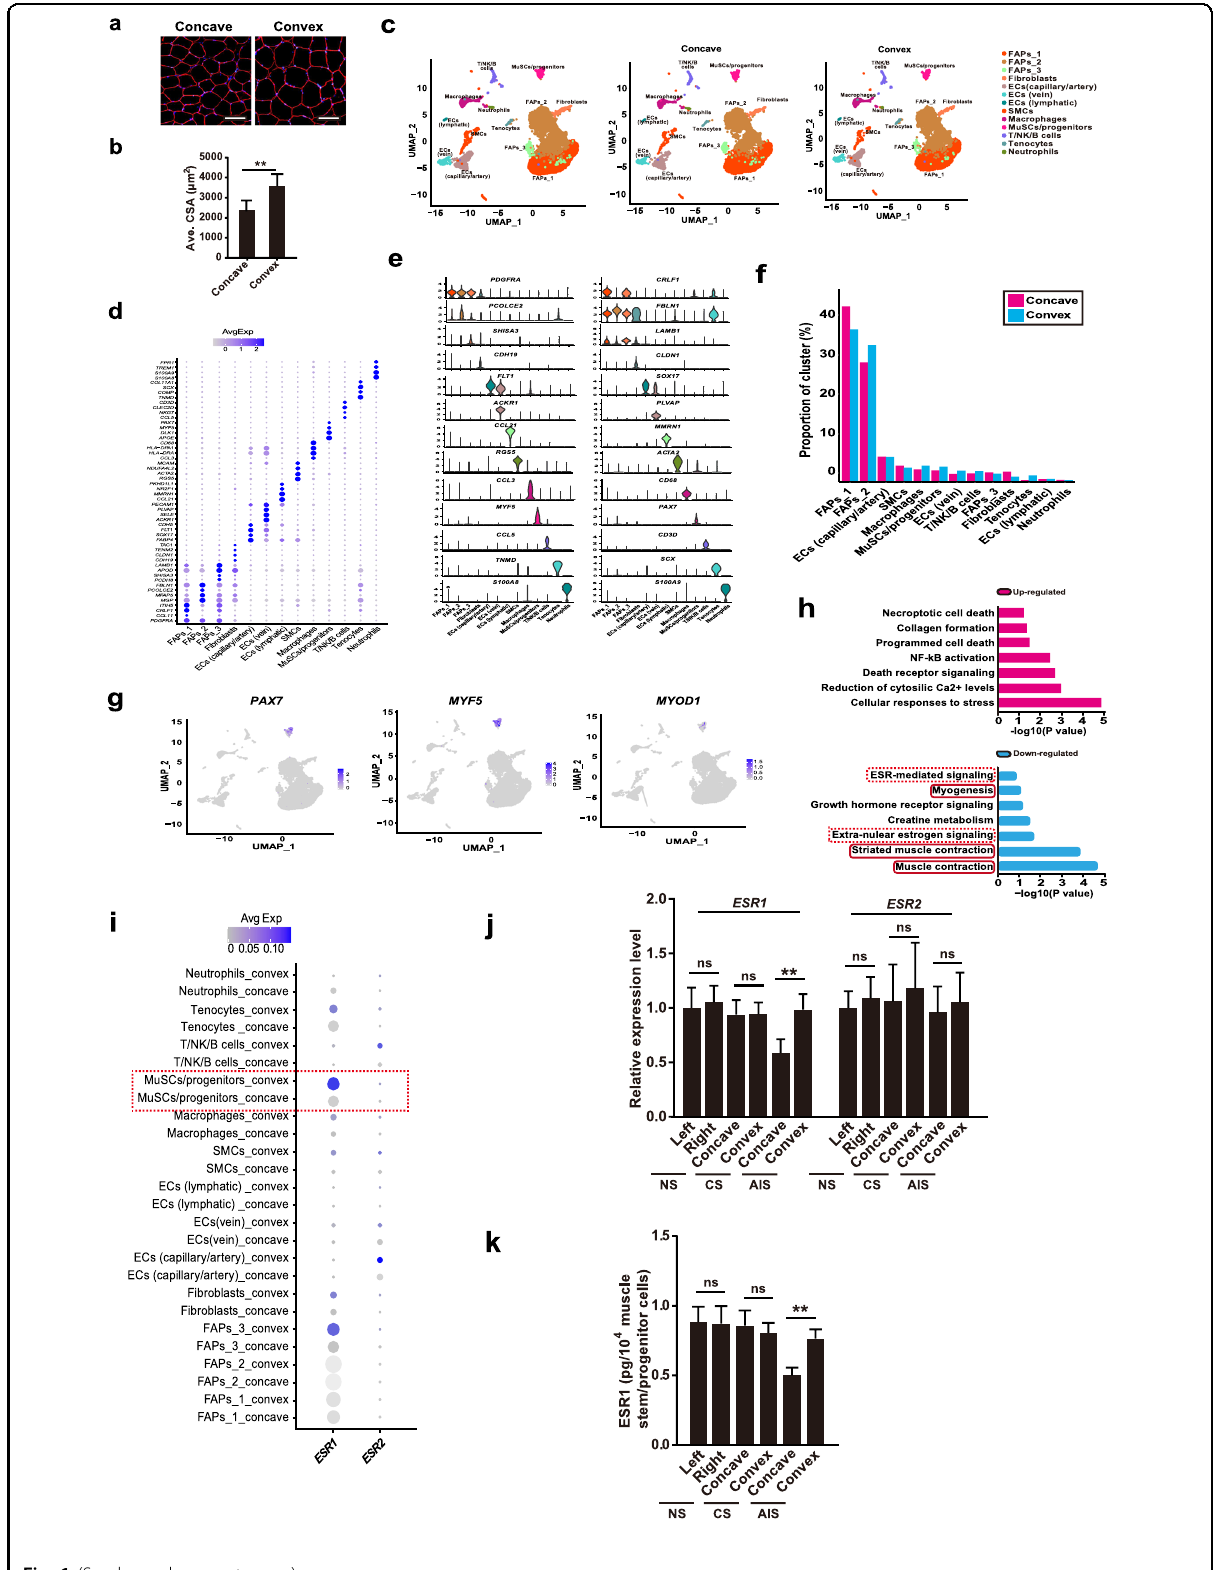
Fig. 1 (See legend on next